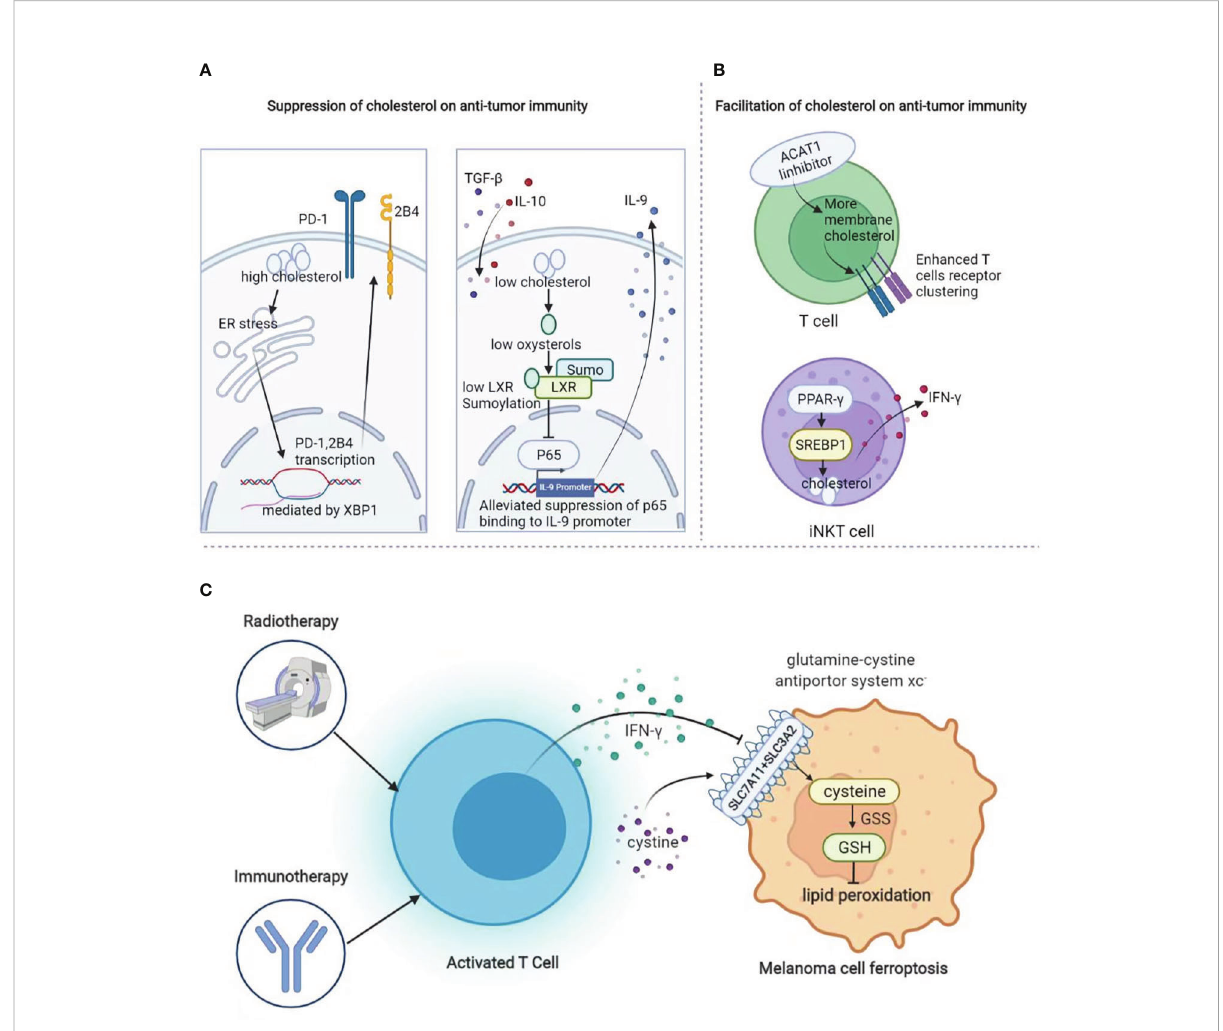
FIGURE 5 The role of lipid metabolism in melanoma immunology. (A) Suppressive role of cholesterol in anti-tumor immunity. Cholesterol promotes the expression of exhaustion-related immune checkpoints in T cells and suppresses the cytotoxic function of Tc9 cells. (B) Facilitative role of cholesterol in anti-tumor immunity. Increase of cholesterol via targeting at ACAT1 causes enhanced T-cell receptor clustering as well as more ef fi cient formation of the immunological synapse. In addition, increased cholesterol biogenesis via PPAR- g could enhance the transcription of SREBF1 to optimize IFN- g production. (C) During radiotherapy and immunotherapy, activated T cells can secret IFN- g to suppress the expression of system Xc - to induce lipid peroxidation and thereby